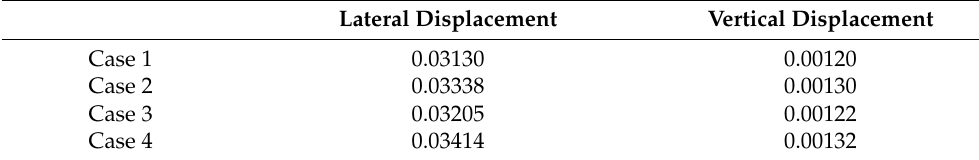
Table 4. The variances of four numerical cases (wind speed 10